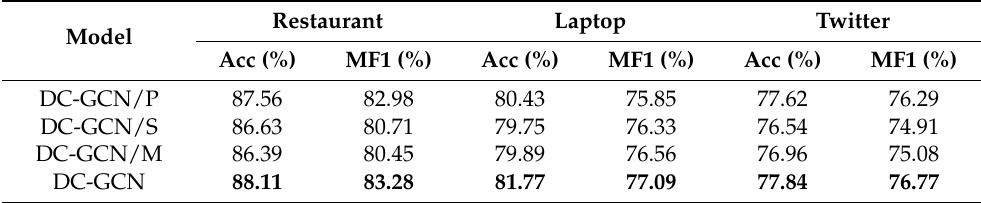
Table 4. Ablation results of different components.